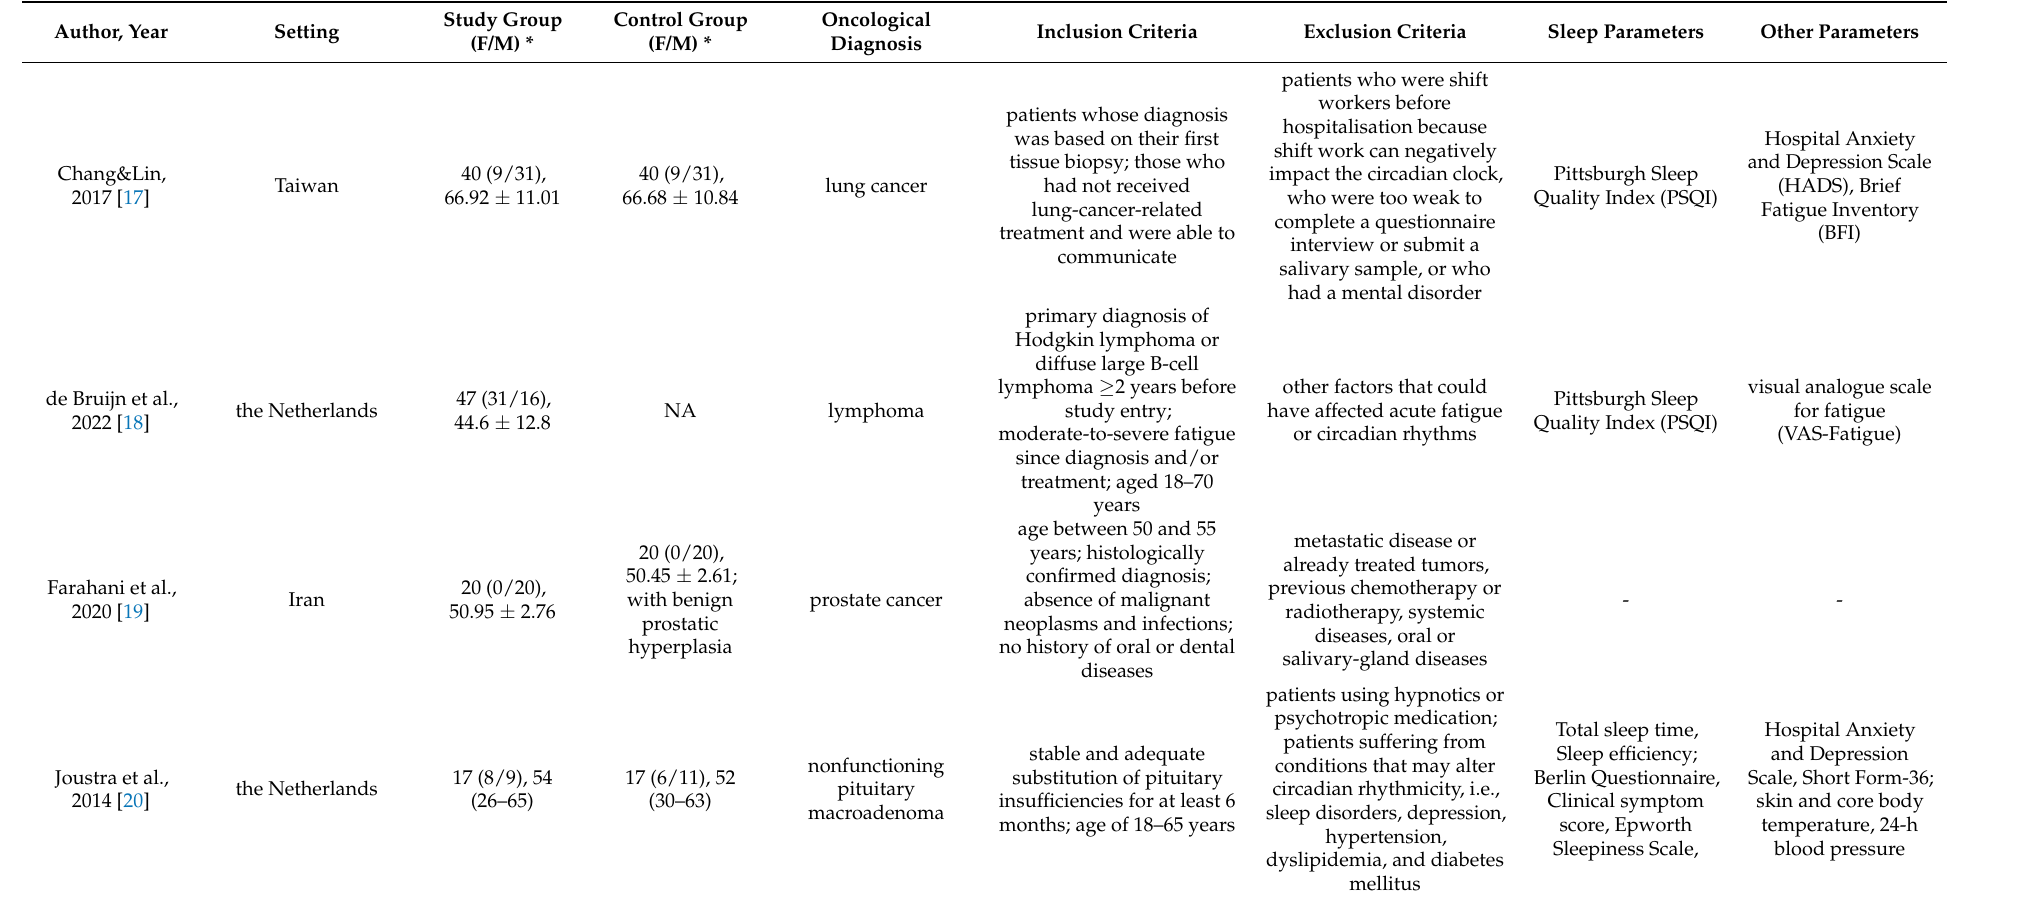
Table 2. General characteristics of included